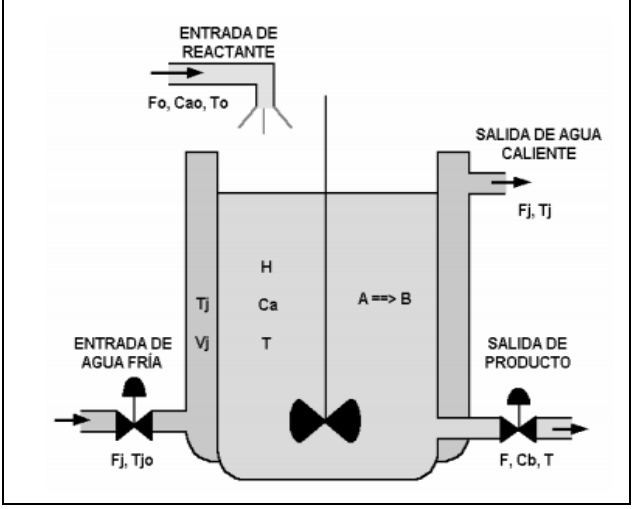
Figura 1: Esquema de un reactor químico tipo tanque continuamente agitado (CSTR) con camisa de enfriamiento y reacción simple exotérmica.